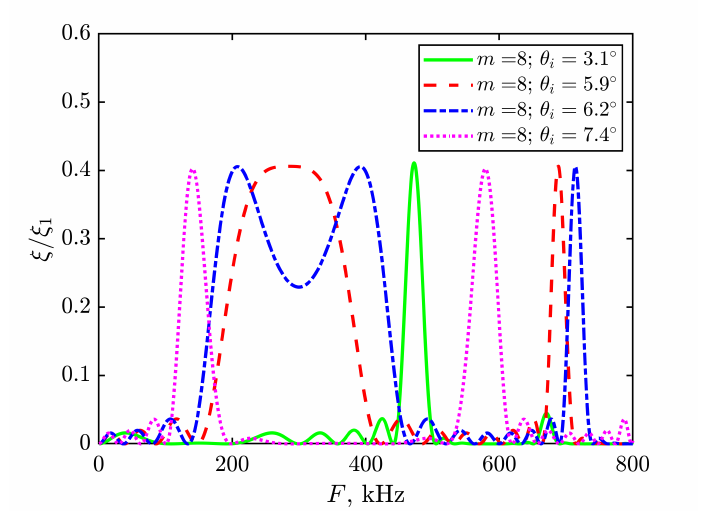
Figure 3. Frequency response of THz AO deflector having an ultrasound transducer with 8 sections for different operating